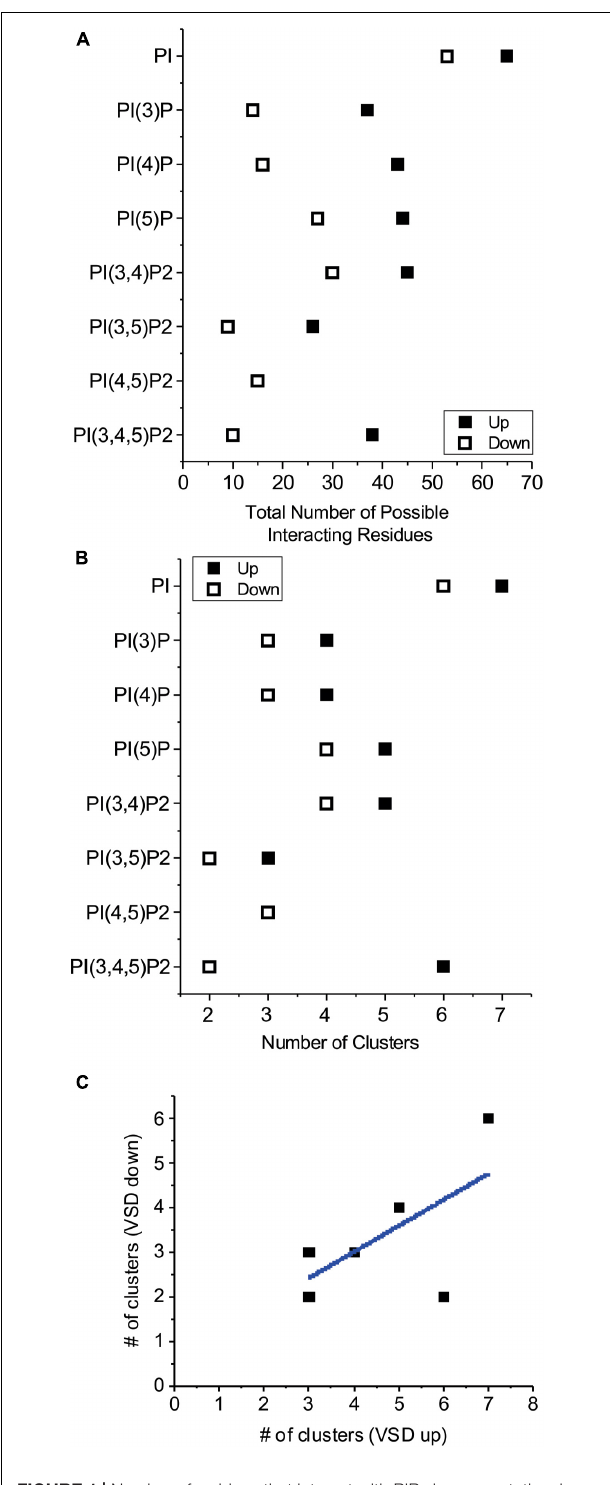
FIGURE 1 | Number of residues that interact with PIPs by computational docking. (A) The total number of residues within 4 Å of any part of the listed ligand in all accepted poses were summed for HCN1 channels with voltage-sensor in the up ( (cid:147) ) or down (